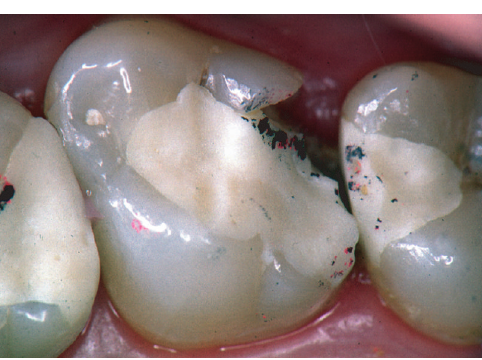
Figure 2: Ketac Molar restoration at baseline. The occlusal contact area was marked with Occlu-foil.